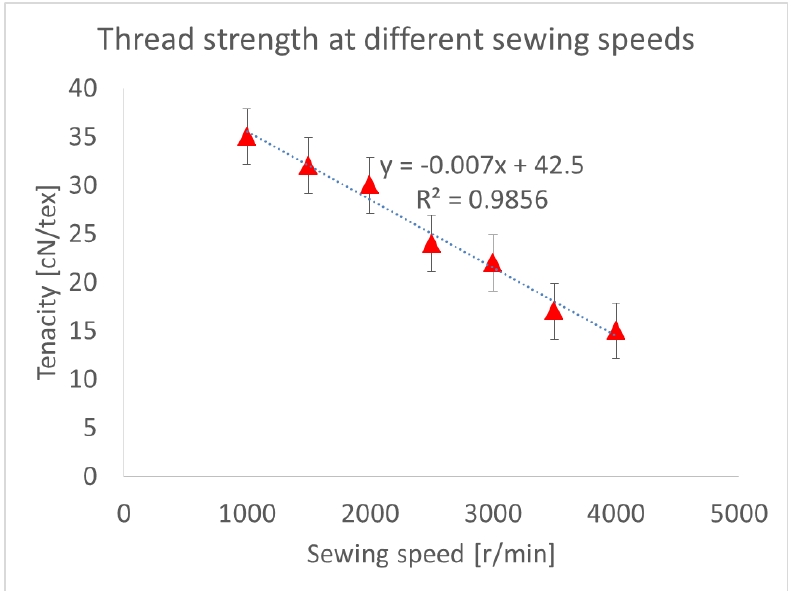
The tensile strength of the sewing thread was measured using ASTM 2256 standards.